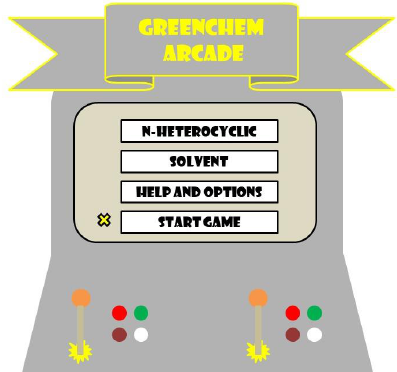
Figure 1. Options for greener synthesis of Nitrogen-Containing Heterocycles.